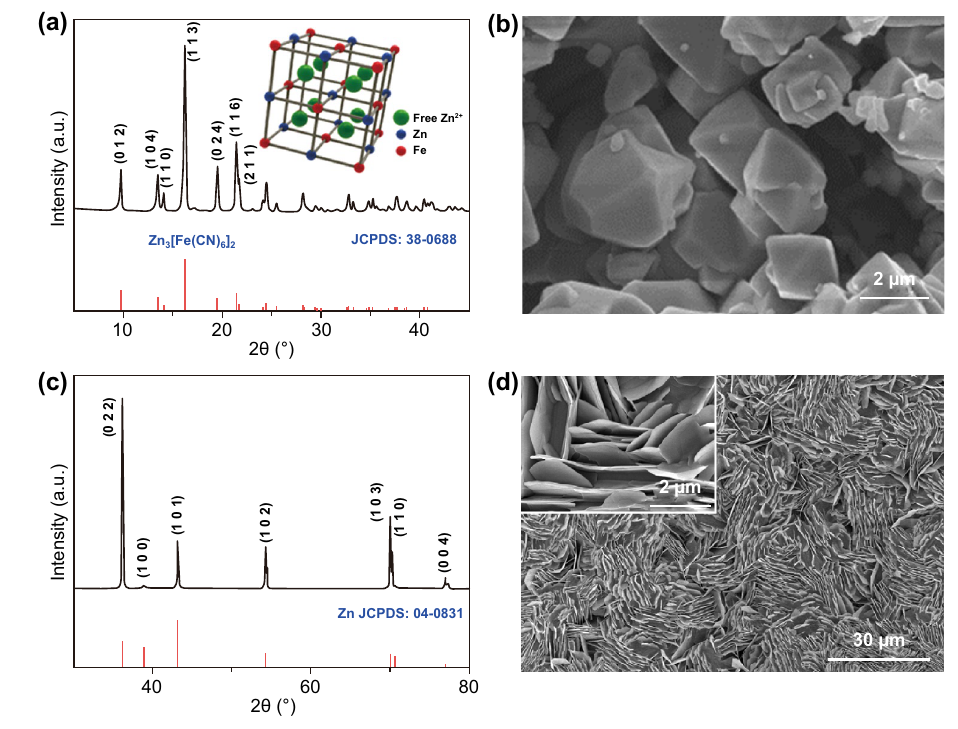
Fig. 1 a XRD patterns of the obtained cathode material and standard card (JCPDS No. 38-0688). Inset is the open-framework atomic configura- tion model. b SEM image of ZnHCF powder. c XRD patterns of the electrodeposited Zn and standard card (JCPDS No. 04-0831). d Low-magni- fication SEM image of the electrodeposited Zn and high-magnification inset in it